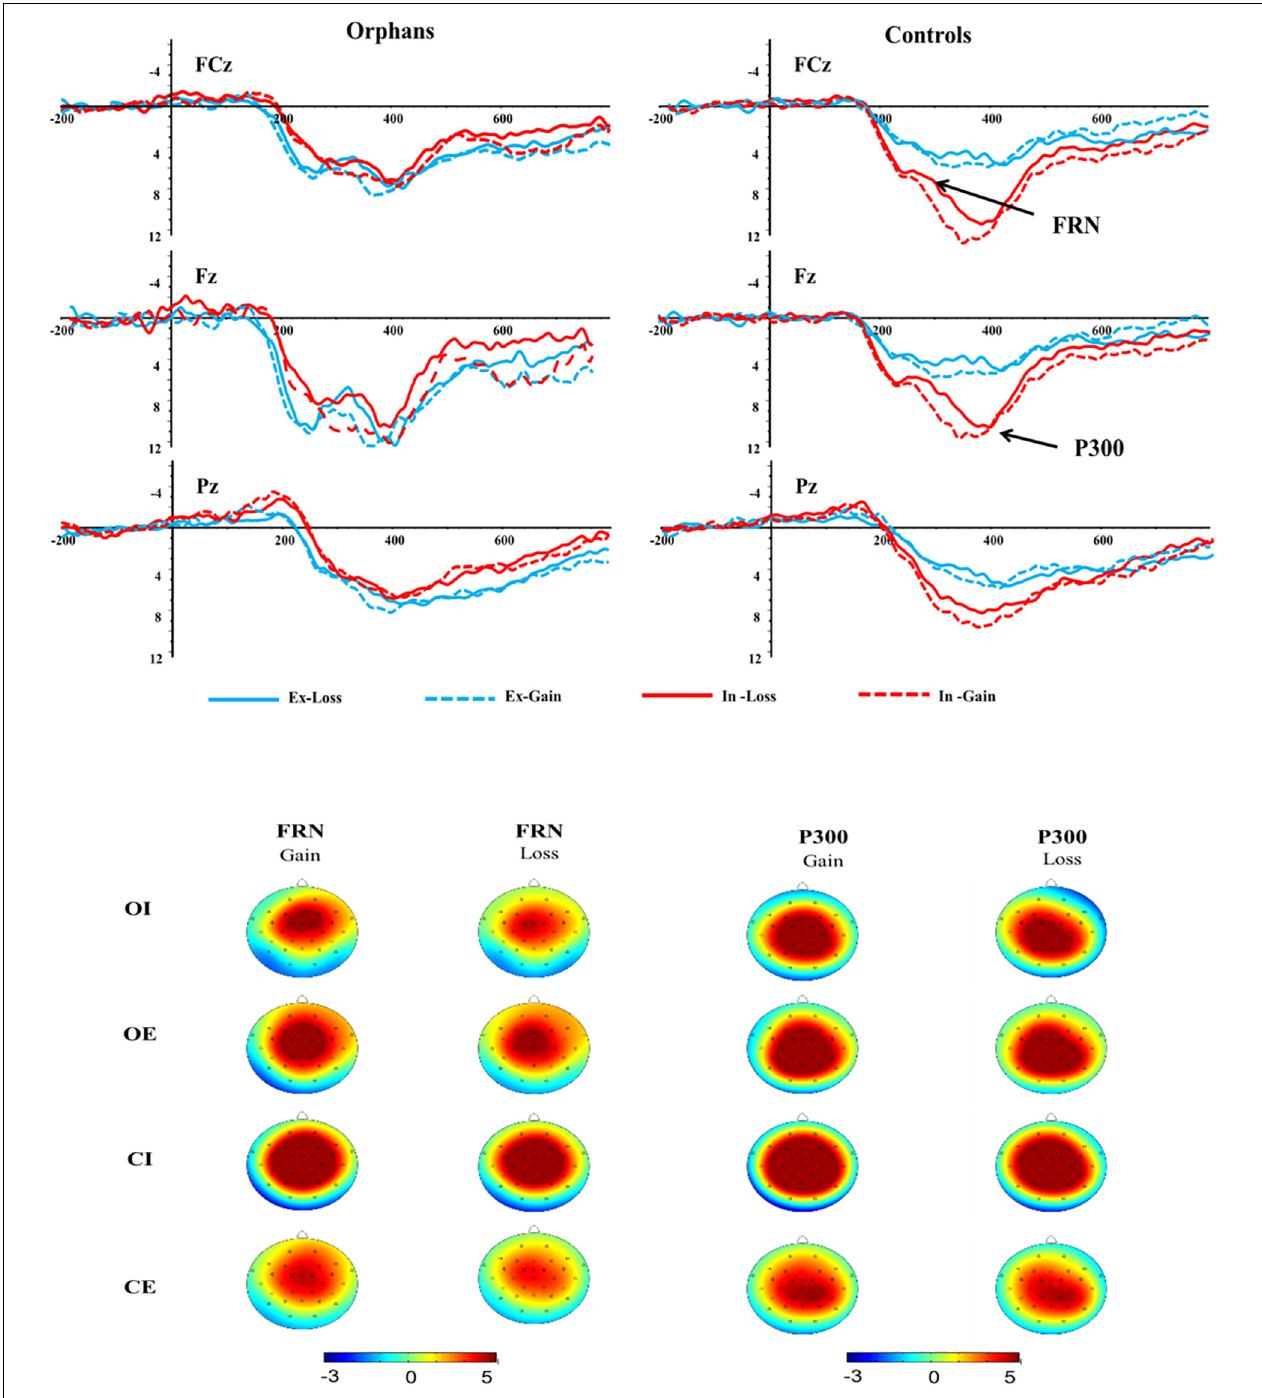
FIGURE 4 | Feedback-related negativity (FRN) and P300 components at FCz, Fz, and Pz electrodes and topographic maps of FRN and P300 scalp